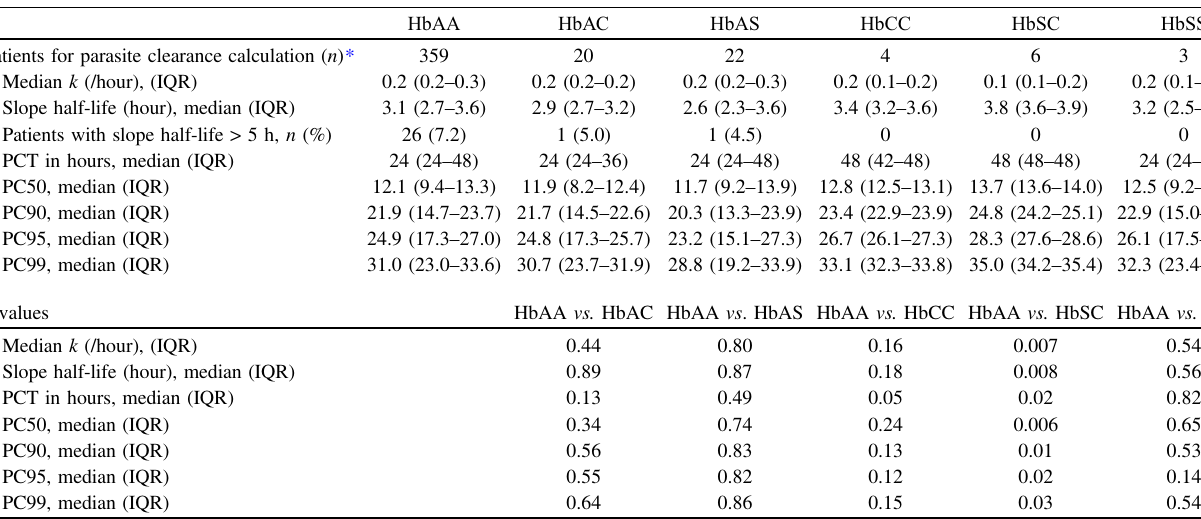
Table 2. Characteristics of parasite clearance according to hemoglobin type.